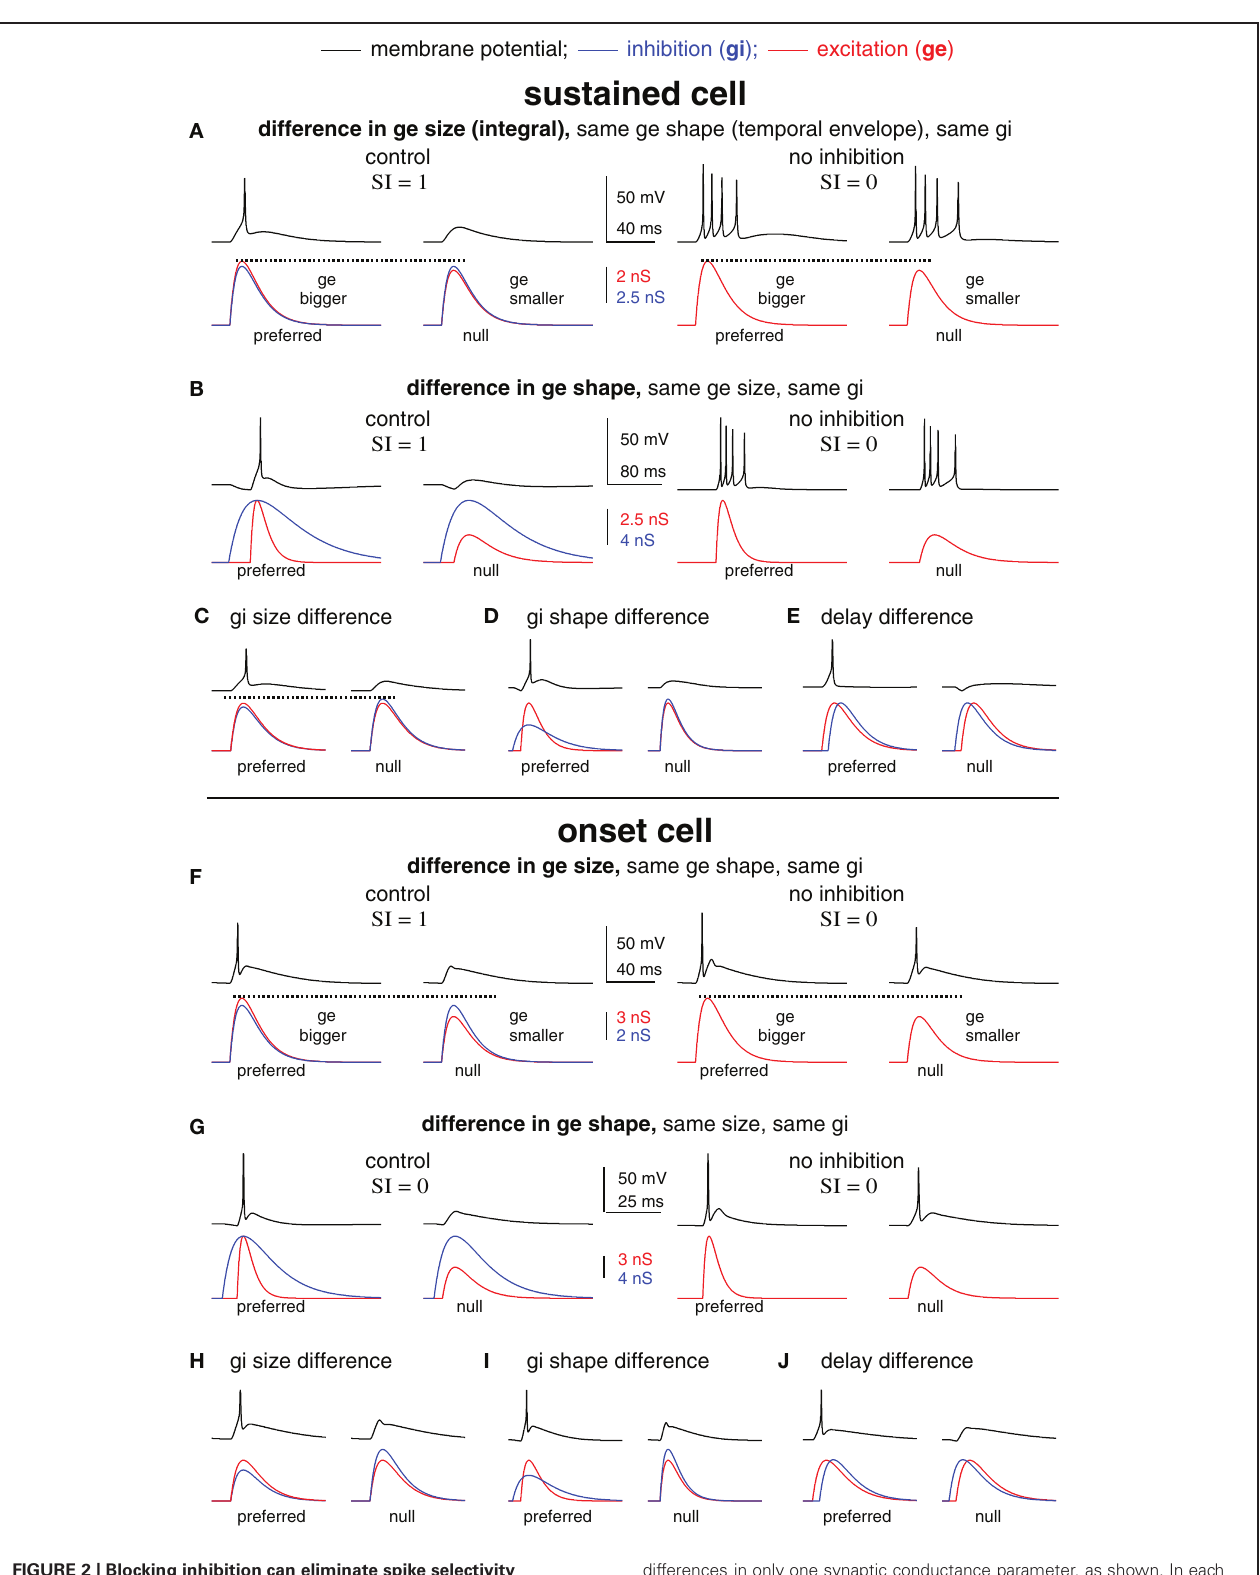
FIGURE 2 | Blocking inhibition can eliminate spike selectivity independent of the underlying mechanism of synaptic selectivity. Spike selectivity is generated by five different mechanisms of synaptic selectivity in a modeled sustained cell (A–E) and onset cell (F–J) . Each mechanism had